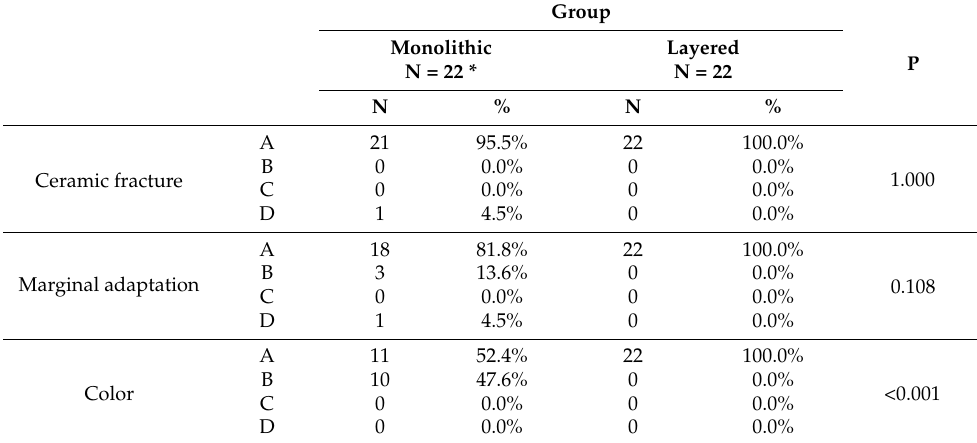
Table 4. Differences in clinical characteristics of crowns between study groups 12 months after cementation: Fisher–Freeman–Halton’s exact